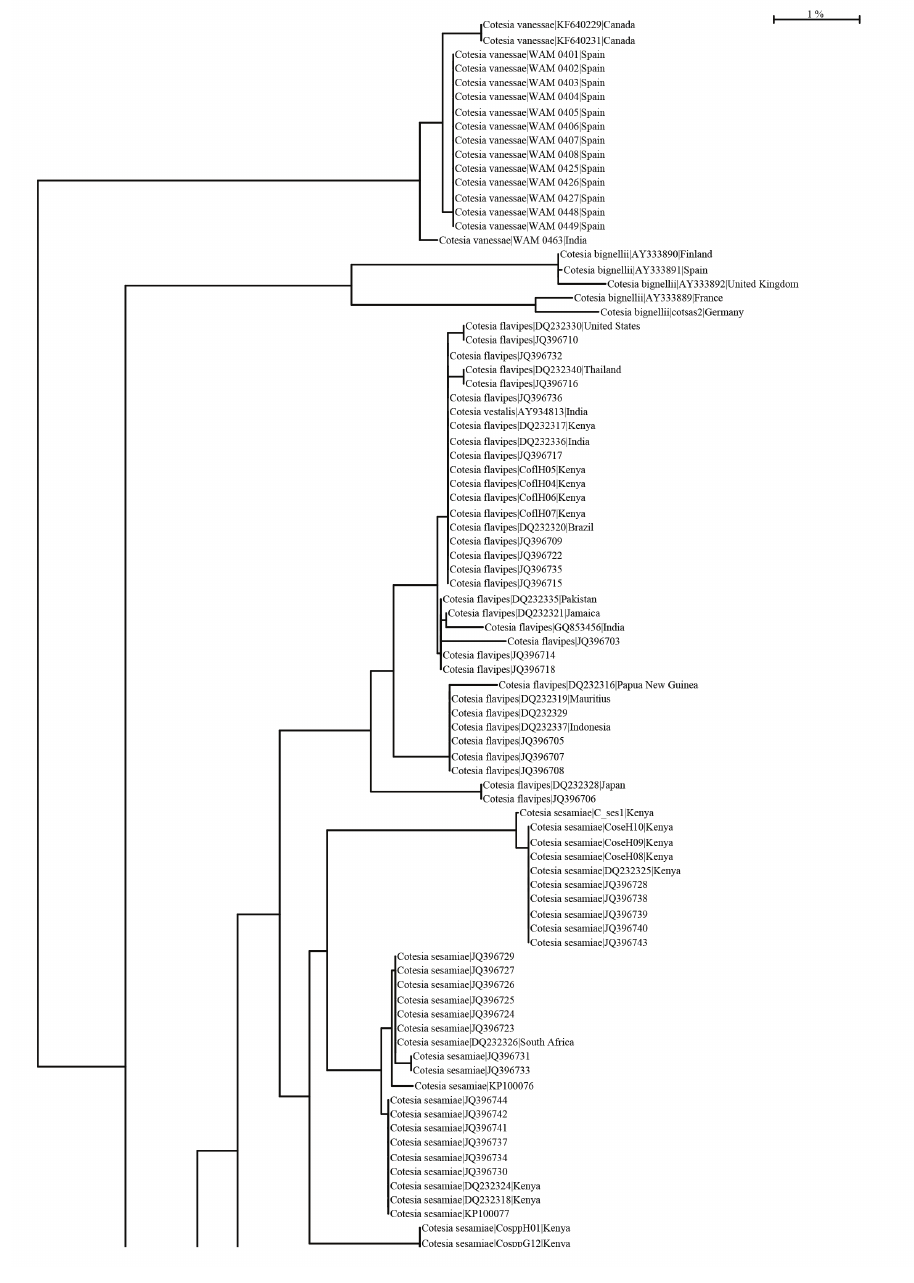
Figure 5. Neighbor-joining tree (K2P) of Afrotropical species of Cotesia in the Barcoding of Life Data System (BOLD) with over 500 base pairs; data accessed on September 2017. Specimens named as “ Cotesia jft52” in BOLD actually belong to the species Cotesia icipe (cluster highlighted in Yellow), and specimens named as “ Cotesia jft68” in BOLD actually belong to the species Cotesia chrysippi (Viereck,